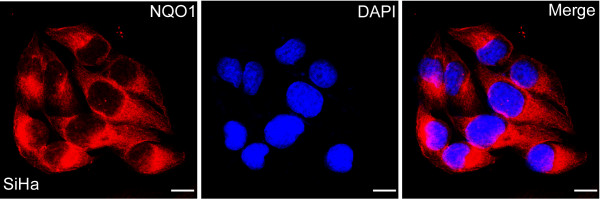
Immunofluorescence staining of the NQO1 protein in SiHa cervical SCC cells. The NQO1 protein was located in the cytoplasm of SiHa cervical SCC cells (red indicates NQO1 staining, blue indicates DAPI).